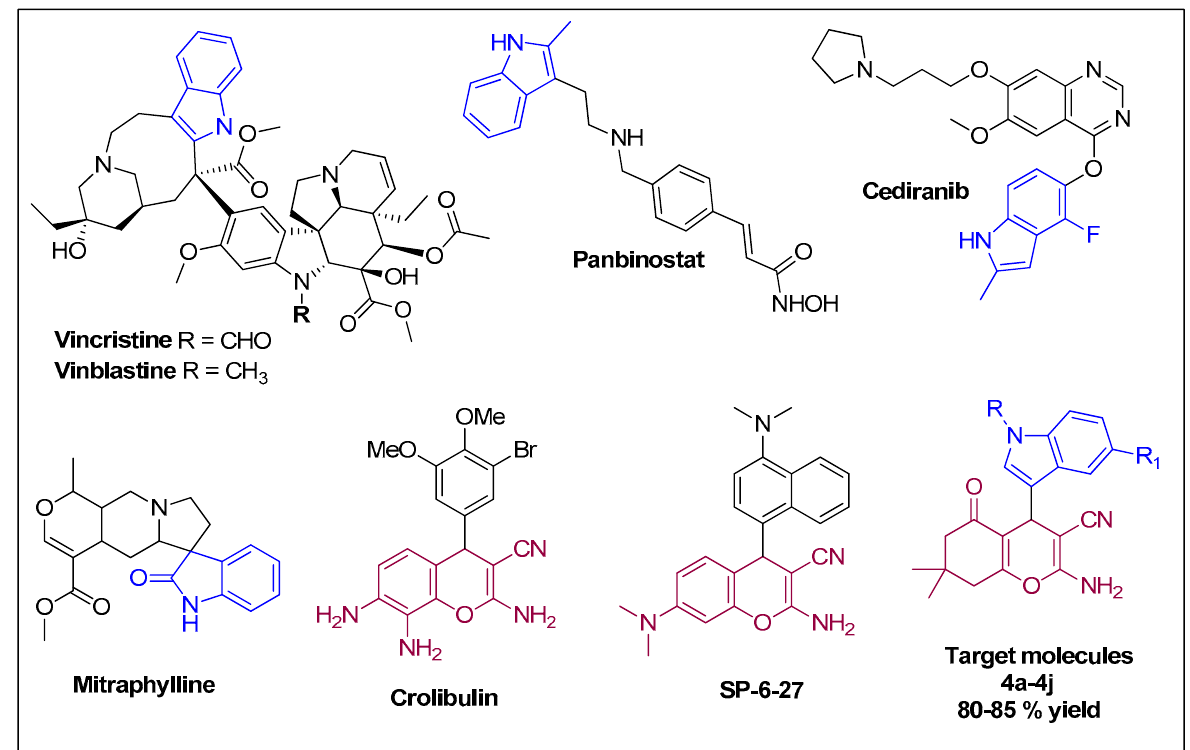
Figure 1. Anticancer agents with indole and chromene moieties.